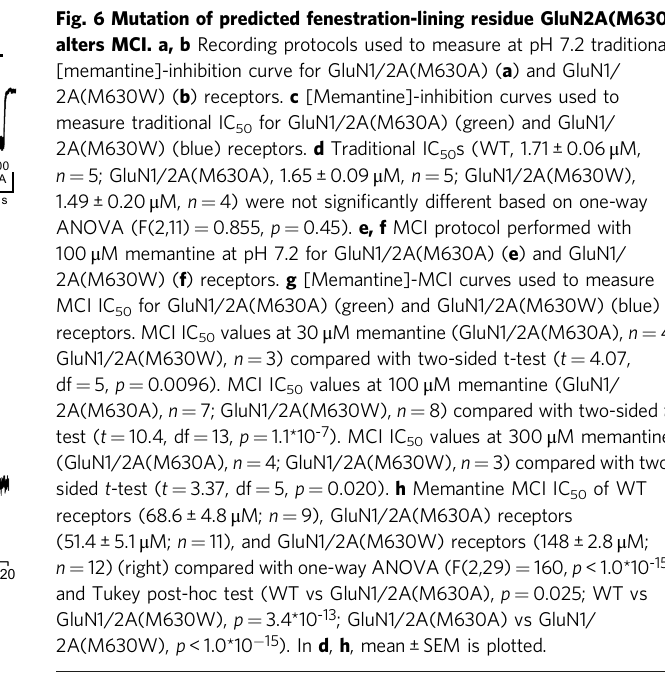
Fig. 6 Mutation of predicted fenestration-lining residue GluN2A(M630) alters MCI. a, b Recording protocols used to measure at pH 7.2 traditional [memantine]-inhibition curve for GluN1/2A(M630A) ( a ) and GluN1/ 2A(M630W) ( b ) receptors. c [Memantine]-inhibition curves used to measure traditional IC 50 for GluN1/2A(M630A) (green) and